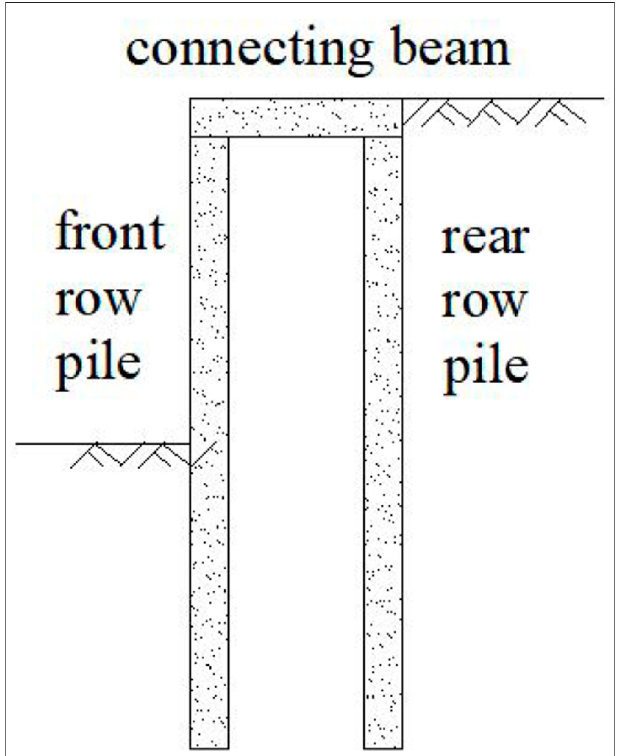
FIGURE 1 | Double-row pile support